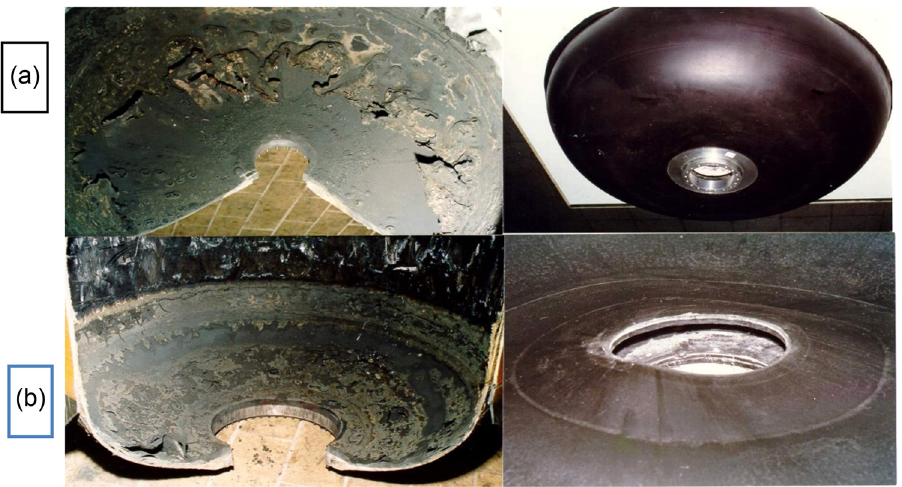
Figure 6: NBR thermal protection: ( a ) front section and ( b ) aft section: after test on test bench. Source: Dr. Dutra ’ s